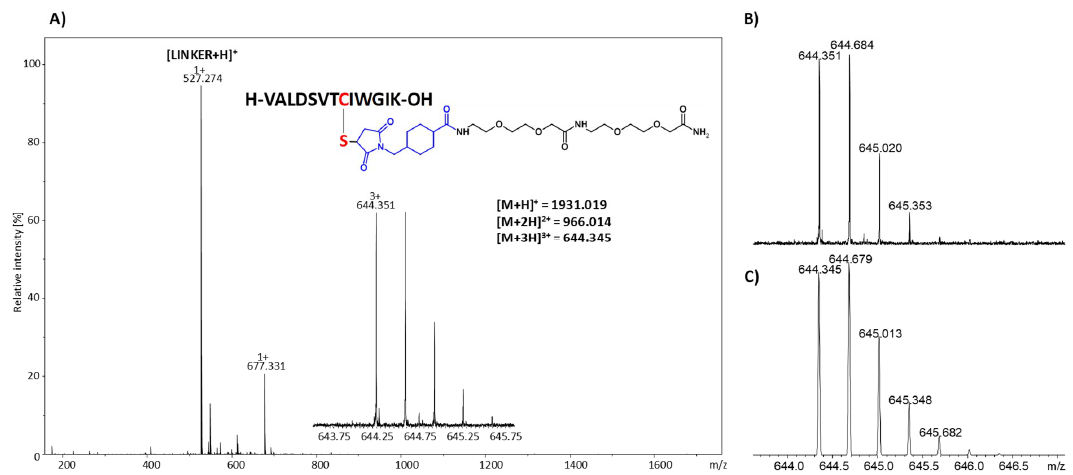
Figure 2. ( A ) Mass spectrum of the obtained product of cysteine-containing podocin tryptic peptide captured using the designed TentaGel resin. The m / z values for di ff erent ion forms of the expected product were present; ( B ) observed and ( C ) theoretical isotopic pattern of the signal corresponding to the [M + 3H] 3 + ion of the final